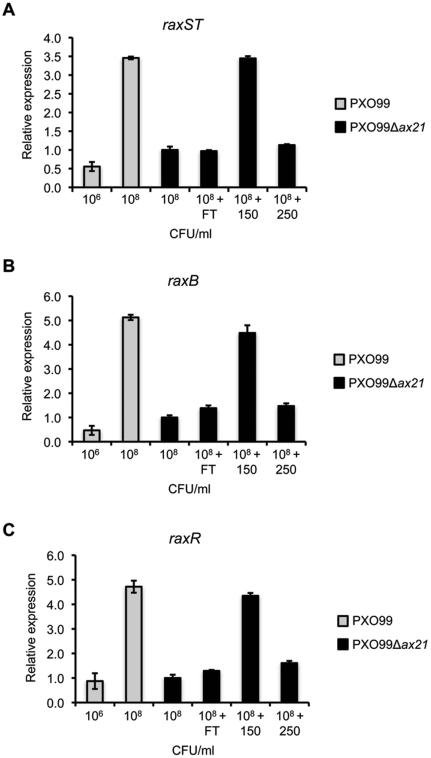
Purified recombinant Ax21 complements density-dependent expression of raxST, raxB, and raxR in PXO99Δax21.
Expression of the raxST, raxB, and raxR genes in PXO99 (106 and 108 CFU/ml, grey), PXO99Δax21 (108 CFU/ml, black), and PXO99Δax21 (108 CFU/ml) supplemented with exogenous addition of the flow-through (FT), 150 mM (150), or 250 mM (250) imidazole buffer-eluted fractions (figure S2) was assessed. Levels of gene expression were calculated relative to 16sRNA expression. Primers specific to each gene are as listed in table S8. Data are mean of four replicates ± standard deviation (SD.).